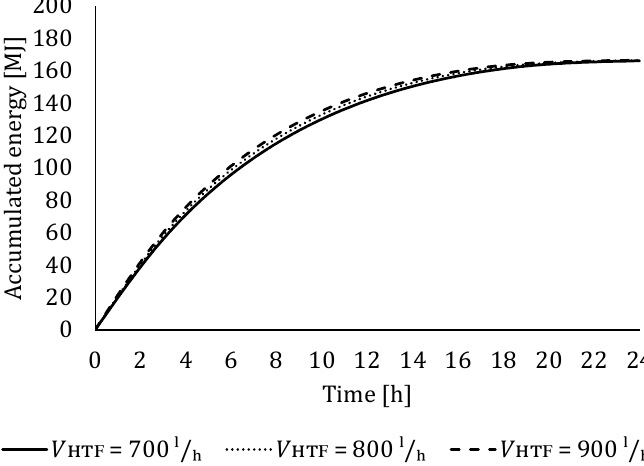
Figure 20. Comparison of accumulated energy during melting obtained numerically for different HTF flow rates, HTF inlet temperature 40 °C and initial PCM temperature 15 °C.